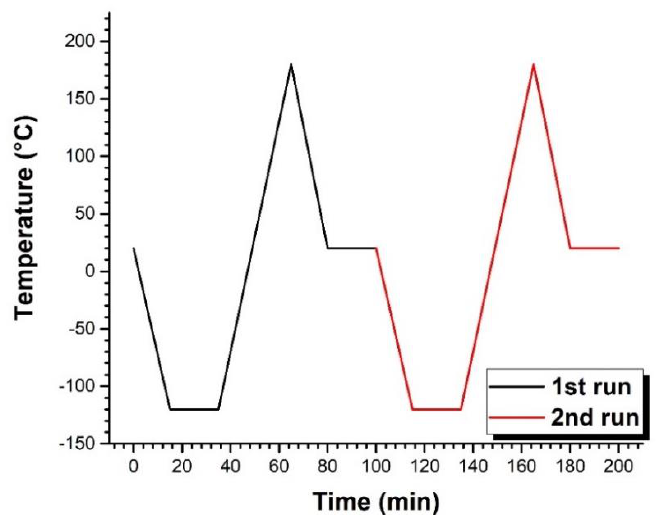
Figure 16 . Thermal cycle for DSC measurements of EVA and EVA/BaTiO 3